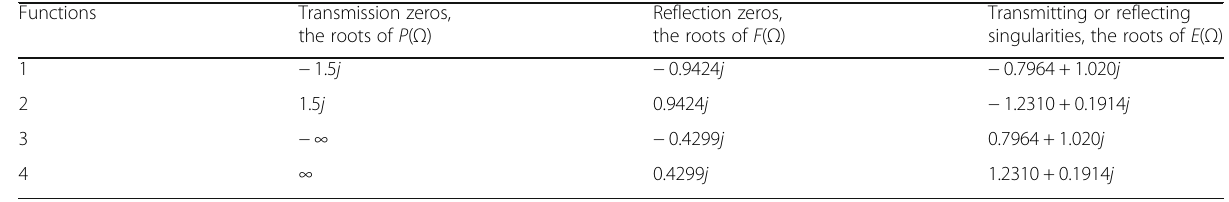
Table 1 Polynomial roots of the four-order single-passband filter Functions Transmission zeros,